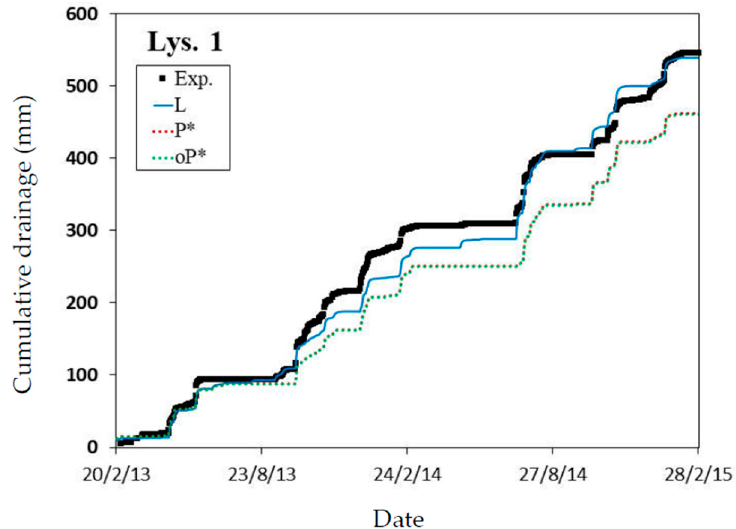
Figure 3. Comparison between experimental and simulated drainage on Lys. 1. L for results obtained with optimized parameters with HYDRUS-1D on lysimeter data; P* for results obtained by applying the mean optimized parameters from the 165 cm deep profile of the three field plots; oP*, the same as P* but for saturated water content values ( θ s * ) again optimized for each soil material.